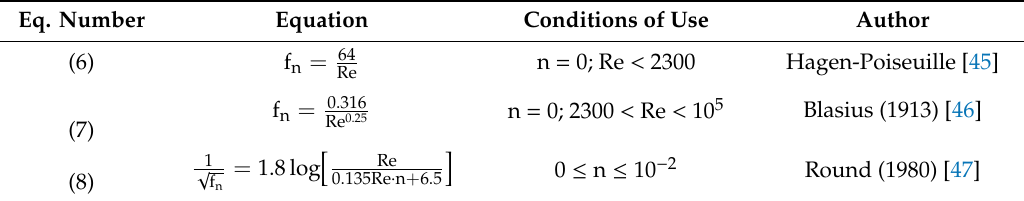
Table 1. Equations for calculation of the fluid flow friction factor used for simulation.